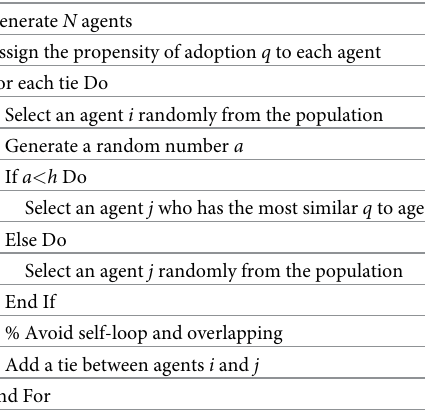
Table 1. Pseudo-code for network